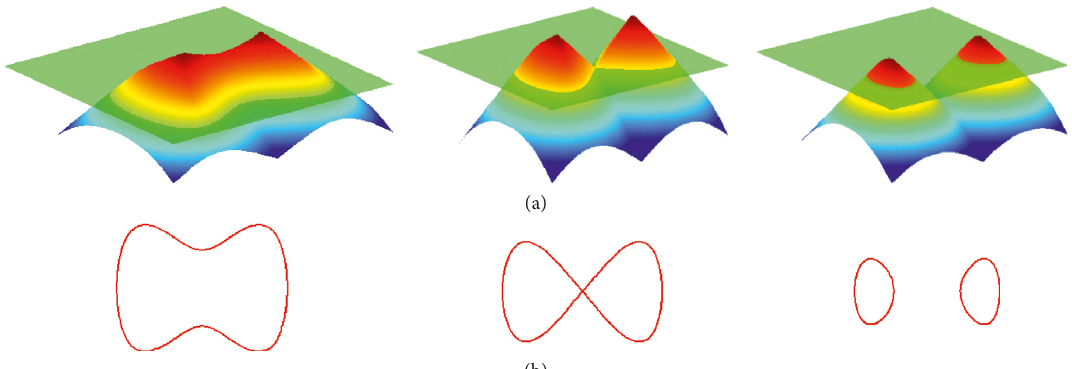
Figure 2: An example of LSE. (a) Level set function and zero horizontal plane. (b) The zero level set corresponding to the level set